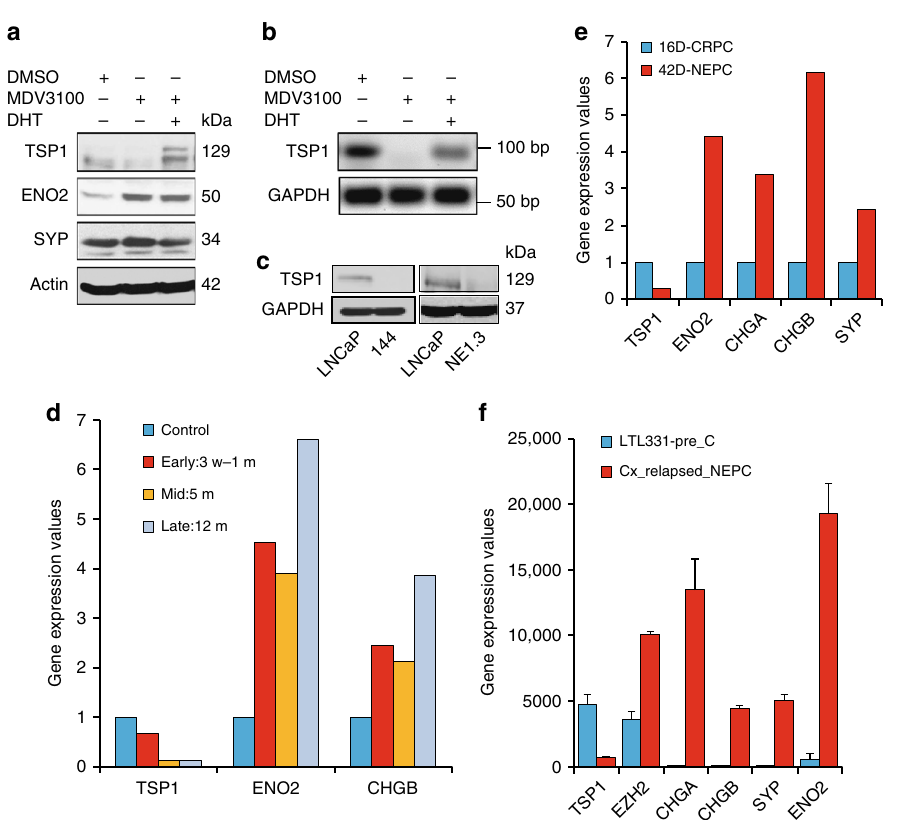
Fig. 7 TSP1 is downregulated by ADT, and repressed in NEPC cells and xenografts models. a Changes of TSP1 protein expression and NE markers in AR- positive LNCaP cells treated with 10 μ M MDV3100 without or with 5 nM androgen DHT for 72 h. b RT-qPCR of TSP1 expression in LNCaP cells treated with 10 μ M MDV3100 without or with 5 nM androgen DHT for 48 h. c Differences in TSP1 protein expression between LNCaP cells and NEPC cells NE1.3 and 144-13. d Mining an independent study (GSE8702) for expression of TSP1 and NE markers after culturing LNCaP cells in CSS media for different lengths of time. e Expression patterns of TSP1 and NE markers obtained from transcript pro fi les of LNCaP xenografts 44 . 16D: xenograft resistant to castration (CRPC). 42D: xenograft resistant to castration and then became resistant to enzalutamide treatment with NE phenotypes. f Examining expression patterns of TSP1, EZH2, and NE markers in prostate cancer PDX transcript pro fi les 45 (European Nucleotide Archive access #: PRJEB9660). Prostate adenocarcinoma PDX tumors LTL331 relapse after castration and become NEPC PDX tumors LTL331R